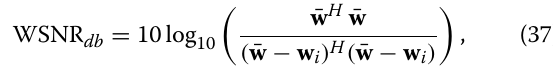
i.e., SMCCC, AMCCC, and CVKW. For reference, the